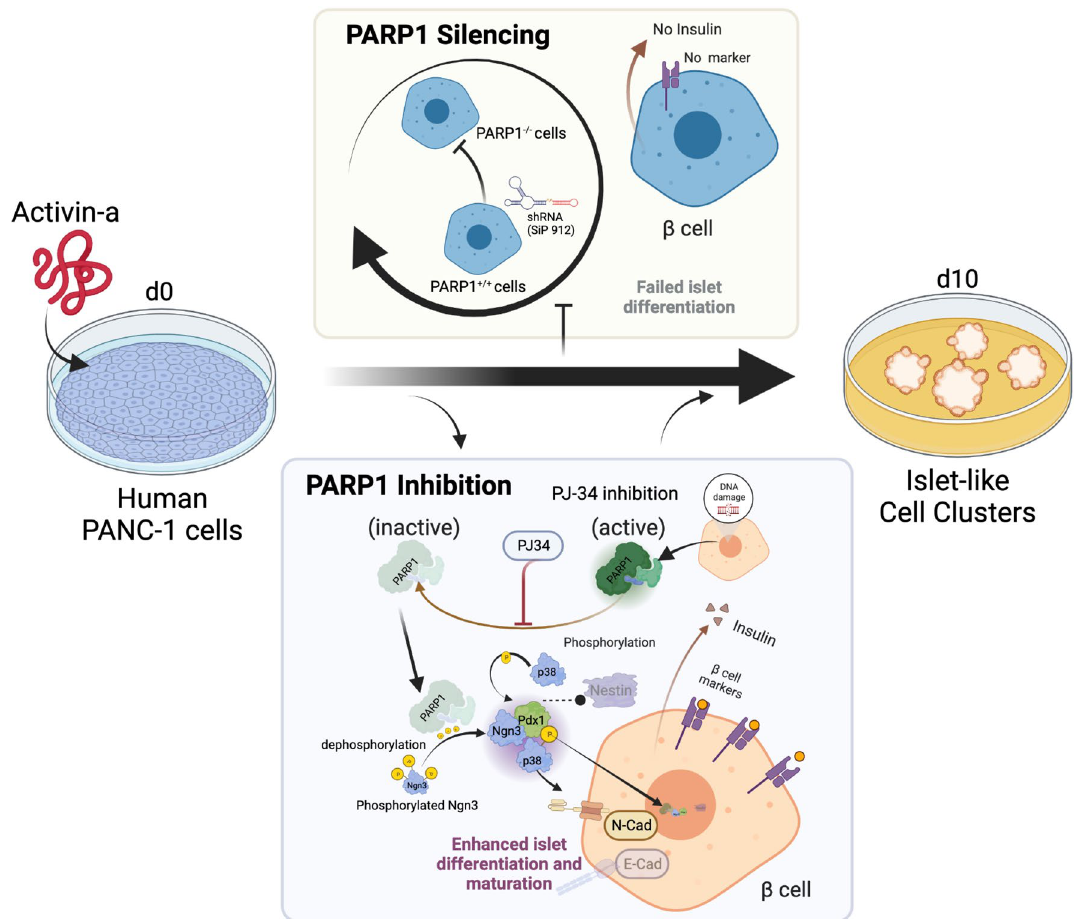
Figure 7. Conceptual illustration describing the mode of action of PARP-1 function in enhancing and activation of islet cell differentiation, maturation and improved β cell production with PJ-34 inhibition while completed abrogation of the process with RNAi mediated PARP1 silencing. The illustration is created using bioRENDER online tool (https:// biore nder. differentiation from stem/ progenitor cell-derived islet regeneration. In Contrast to PARP1 KO animals where Ngn3 expression was observed without nestin staining, RNAi-induced PARP1 SiP cells showed basal nestin trig- ger without stimulating Ngn3 activation. We believe that Nestin and Ngn3 arm for human islet cell differentia- tion and maturation might progress distinctly than in mice pancreas development, such as in PARP1-KO mice. Although RNAi-mediated PARP1 knockdown could suppress nearly > 95% of protein expression, a minimal residual protein may influence basal signal transduction but is incapable enough to stimulate ngn3 activation and induce islet cell differentiation. Our data from this study concludes that the absence of PARP1 in KO mice defines immature islets with increased but small size suggesting halted progenitors during morphogenesis. This was not observed when mimicked with RNAi-mediated PARP1-depleted human PANC-1-islets. Based on these substantial datasets using PARP1 KO mice and PANC-1 line differentiated islets with phar- macological and gene manipulation approach, we hypothesize that the presence of PARP1 protein, but not its catalytic activation, is essential for forming functional islet clusters with activin-A (summarized data shown in Table 1). We also suggest that PARP-activation may negatively influence this event (Fig. 7). Our results reflected the two earlier observations in a simpler model of only β-cell lines that PARP-inhibitor could promote tran- scription of Reg-1 6 and MafA 29 genes, which are implicated in β-cell proliferation or insulin gene expression, respectively. Unlike these studies that involved only mature β cells, our model requires differentiation of precursor cells to islet-like clusters for insulin and glucagon-producing cell generation, thereby mimicking the embryonic pancreatic ontology for islet development artificially. In addition, as PARP is known to have a role in chromatin remodelling and transcriptional activation or repression in different contexts of the genome, we believe that unmodified PARP1 is implicated in transcriptional reprogramming of many genes that govern optimal islet formation from stem/ progenitor cells.